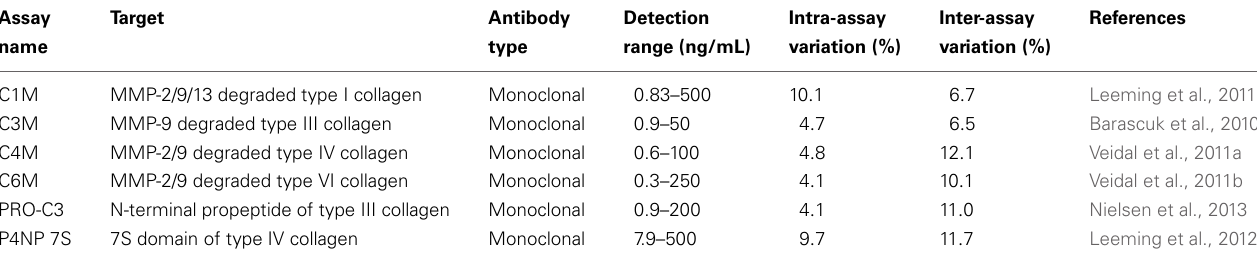
Table 1 | Overview of used degradation and formation markers of ECM.